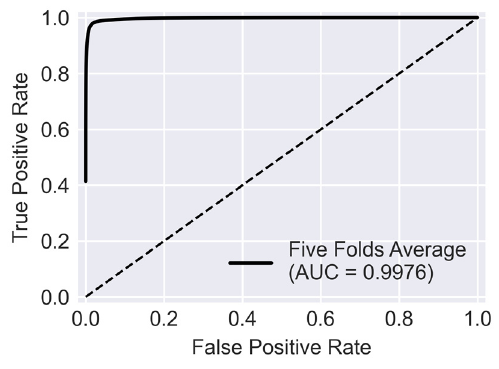
Figure 8. ROC curve for five folds of